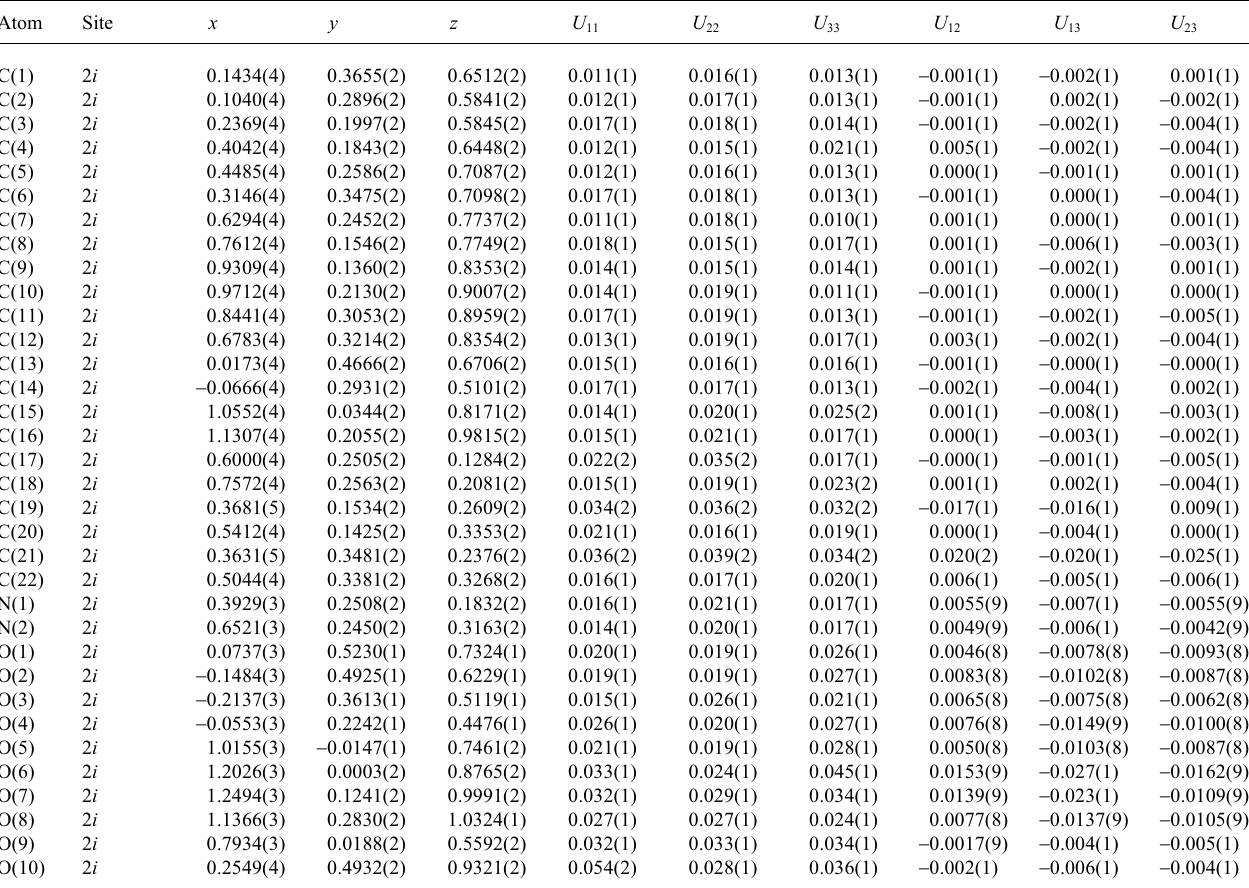
Table 3. Atomic coordinates and displacement parameters (in Å 2